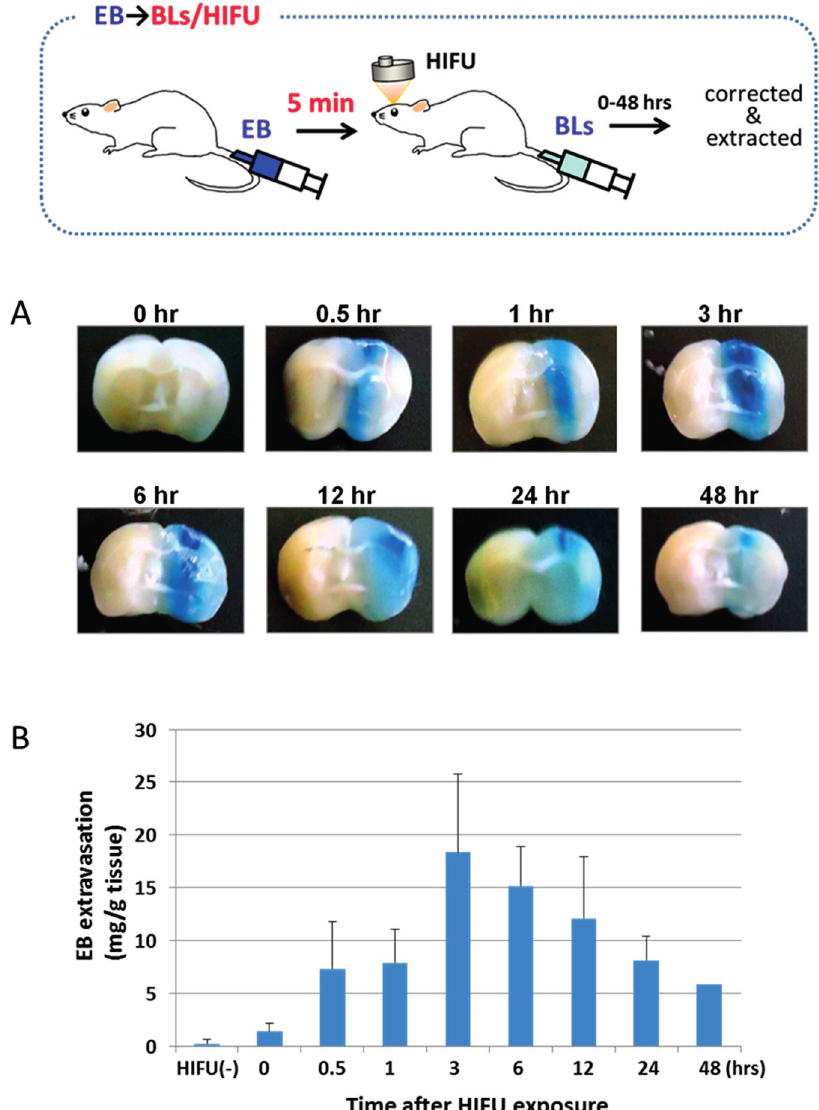
Figure 1. EB extravasation in the brain as a function of time after HIFU exposure. ( A ) Distribution of BBB disruption by extravasation of EB. Right brain: HIFU-exposed site. Left brain: control (non-exposed site). ( B ) The amount of EB extravasation in the right brain. The mice were injected into the tail vein with EB 100 mg/kg. After 5 min, they were injected with Bubble liposomes (100 μ g/mouse) and exposed to HIFU with 3.5 MHz, 10% duty, 1.5 kw/cm 2 , and 60 s. After the treatment, each tissue was corrected at the indicated time. Each value represents the mean S.D. ( n = 6). EB: Evans blue, BL: Bubble